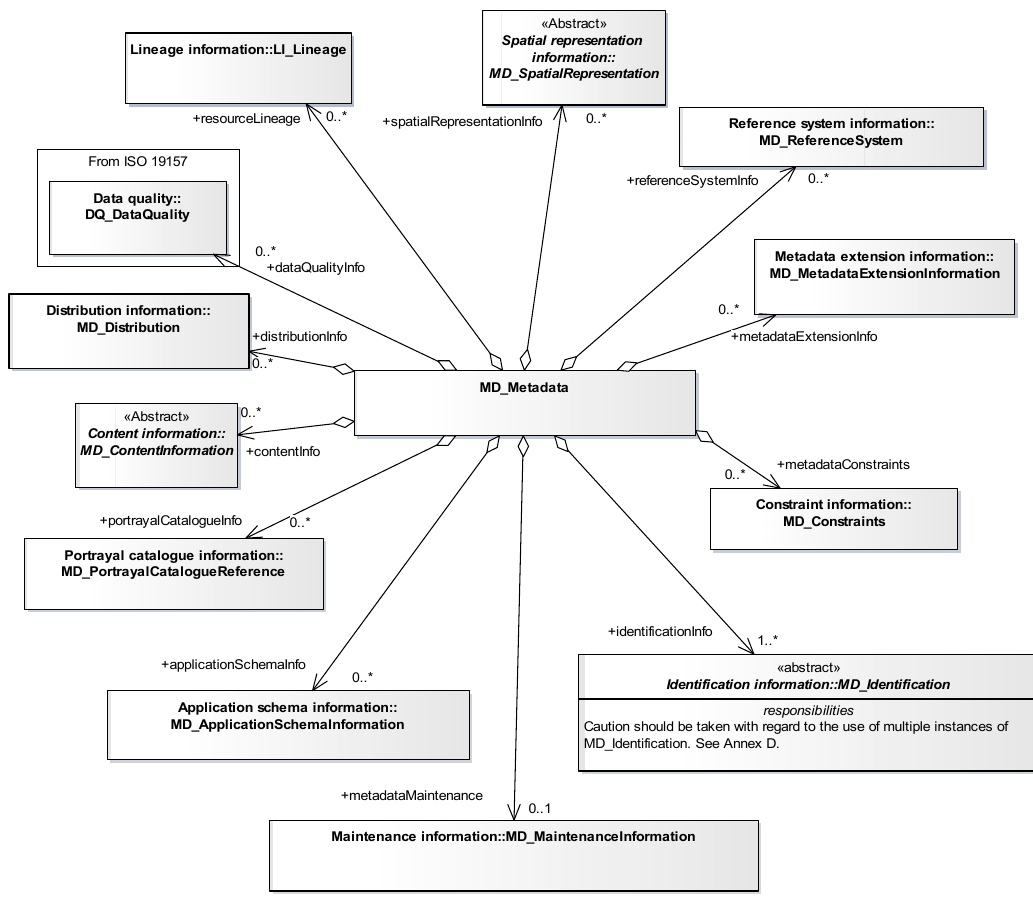
Figure 2. ISO 19115-1 high level metadata structure. Table 3. Summary of the ISO 19115-1 high level metadata classes.